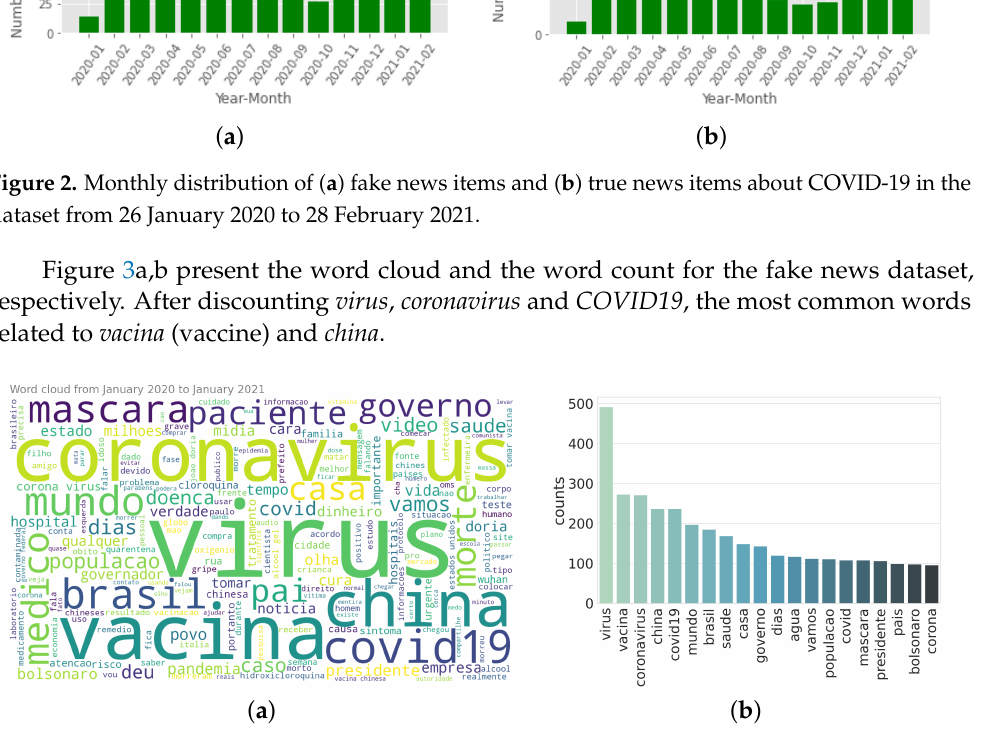
Figure 3. Word cloud ( a ) and word count ( b ) for the most popular words in the fake news